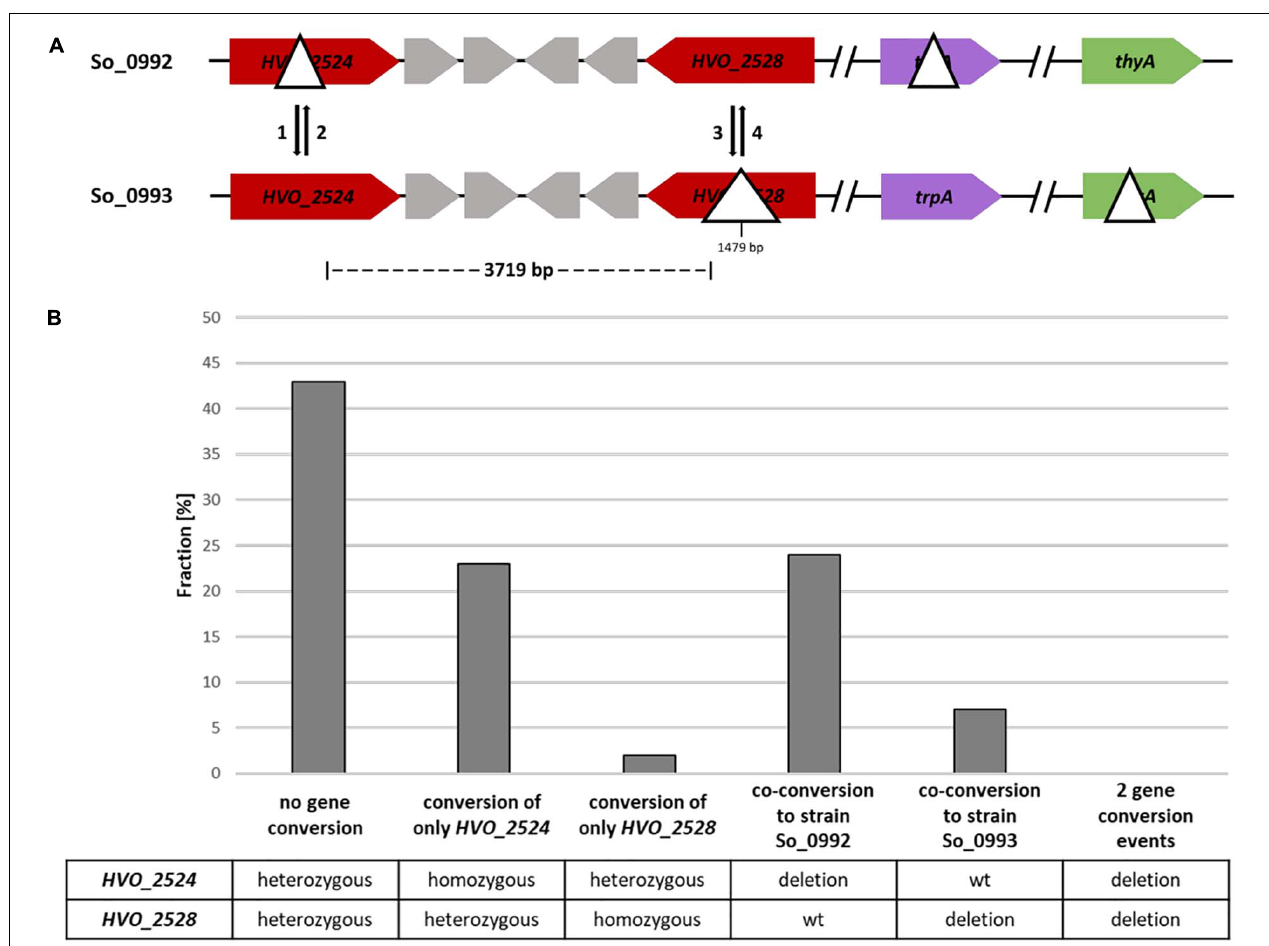
FIGURE 4 | A gene conversion experiment including two sites with a distance of 3,719 bp. (A) Design of the experiment. The sizes of the internal deletions and the genomic distance between them are indicated. The numbers 1–4 indicate the possible gene conversion events. (B) Results of the experiment. Ninety five randomly chosen white clones were analyzed by PCR with primers that were specific for the two possible gene conversion sites. The fractions (%) of clones are shown that exhibited gene conversion at none, one or two of the sites. One biological replicate was